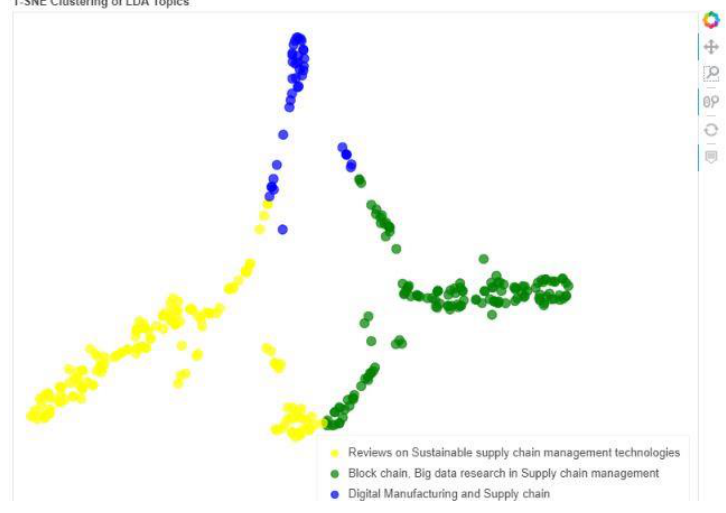
Figure 8. Clustering on “Title”.